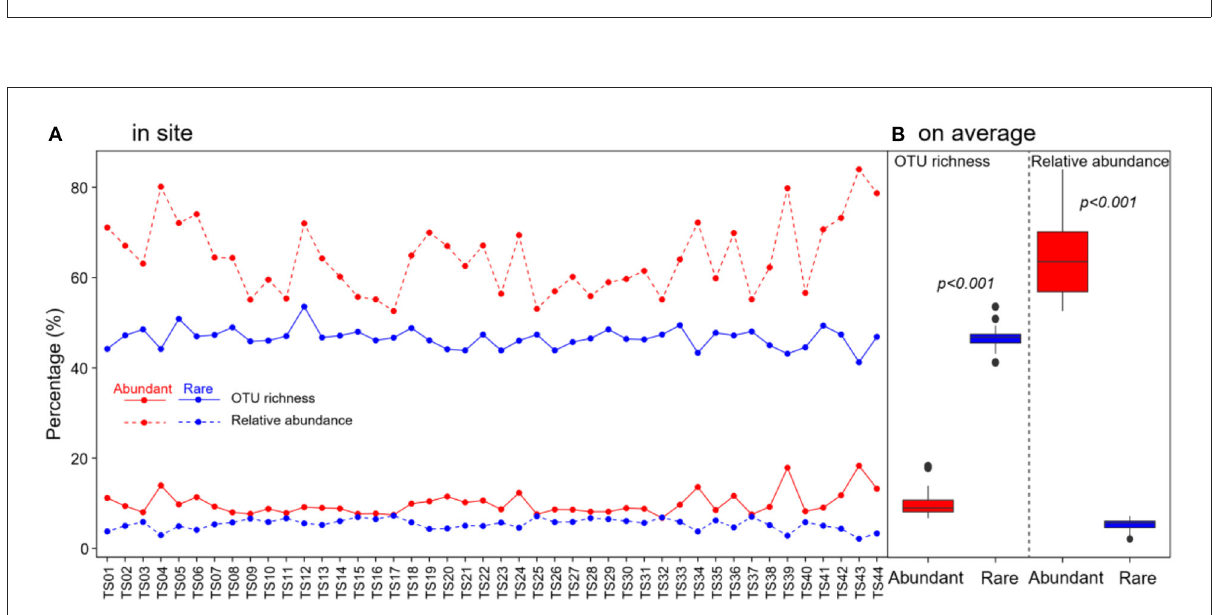
FIGURE2 Distribution of OTU richness and relative abundance of abundant and rare bacterial taxa in thermokarst lake sediment (A) in each lake and (B) on average across the